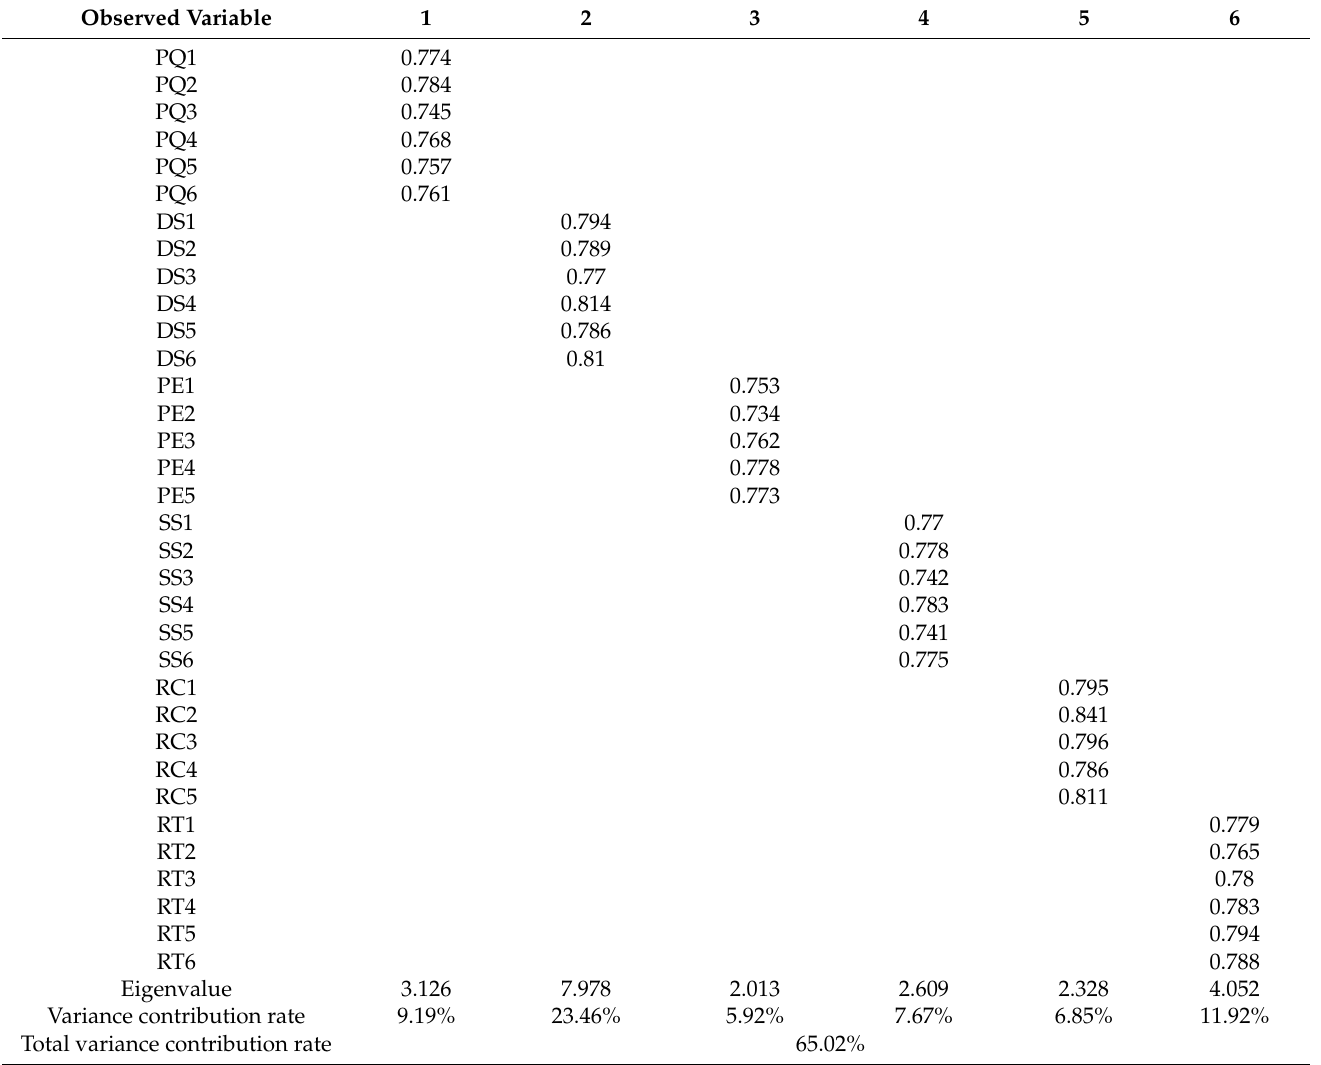
Table A1. The main information of exploratory factor